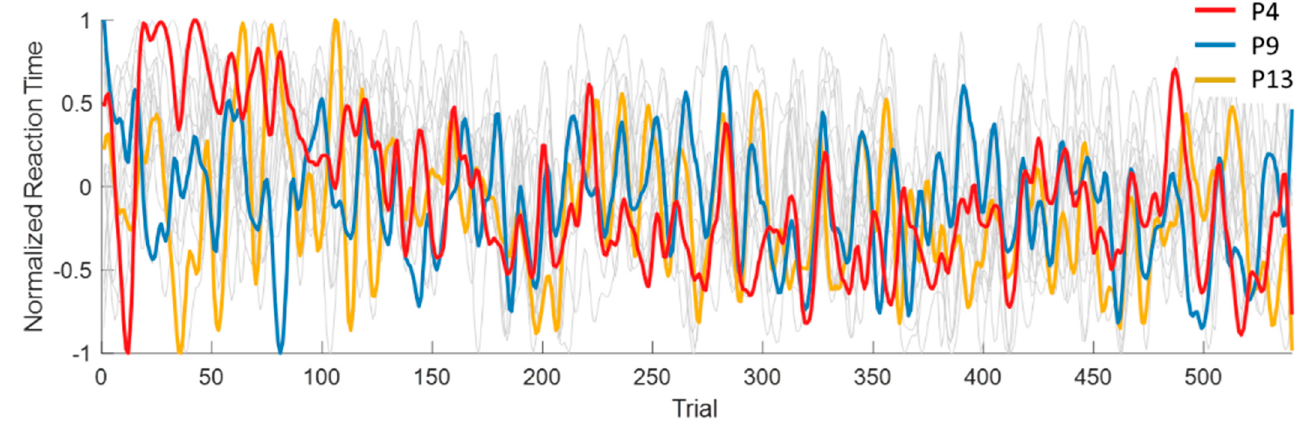
Figure 3. Normalized reaction time for all participants with Participant 4 (P4), Participant 9 (P9), and Participant 13 (P13) highlighted.